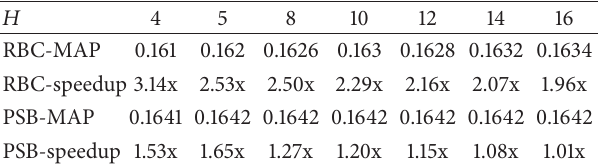
Table 4: MAP and speedup variations with H on Corel 10K ( 𝑆 = 800, 𝑇 = 700 ).